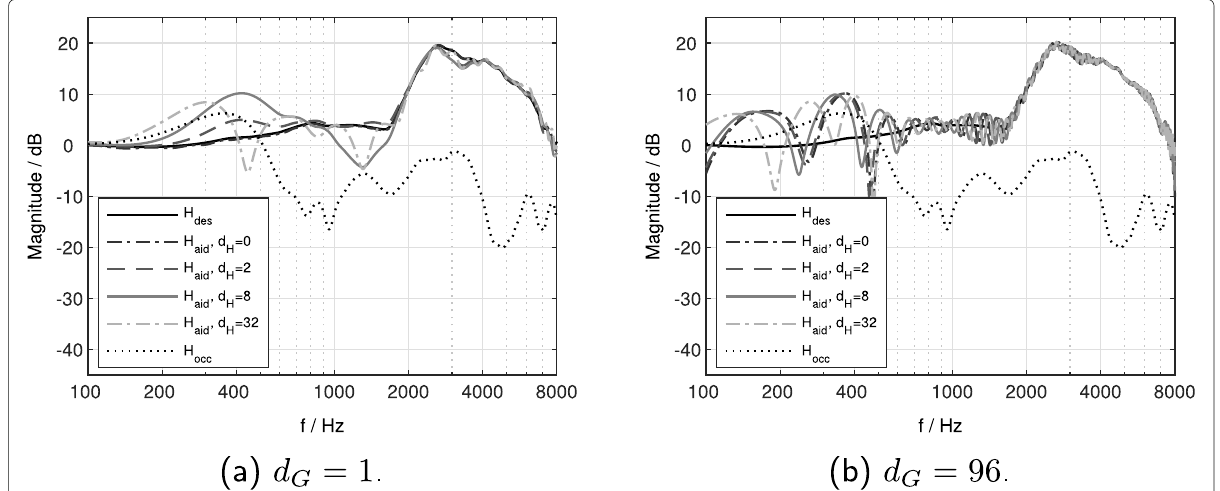
Fig. 4 Magnitude responses of the occluded ear transfer function H occ ( q ) , the aided ear transfer function H aid ( q ) and the desired open ear transfer function H des ( q ) for different values of d H using N = 2 loudspeakers, and G 0 = 0dB for a d G = 1 and b d G =